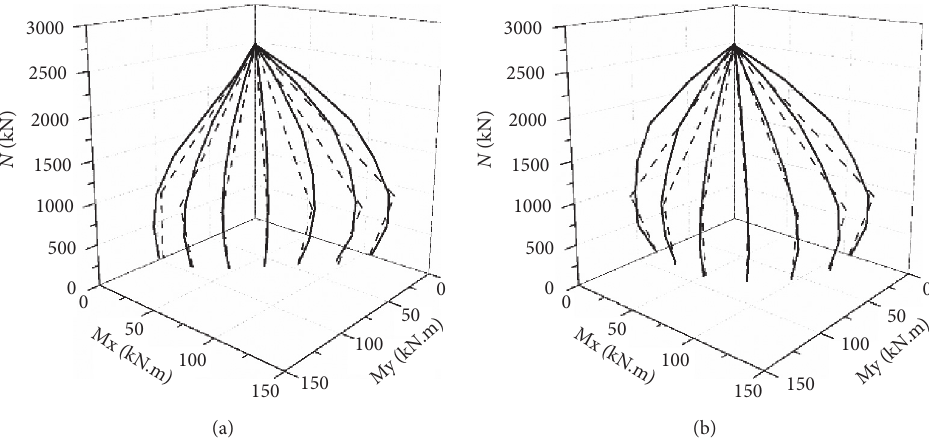
Figure 26: Verification of simplified N-M resistance model of columns in different loading angles ( − 90 ° –90 ° ). (a) Positive loading (0–90 ° ). (b) Negative loading ( − 90 ° ∼